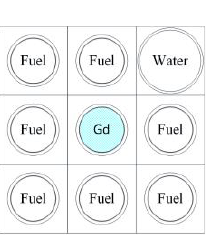
Figure 4. Configuration of the 3×3 pins with gadolinia.